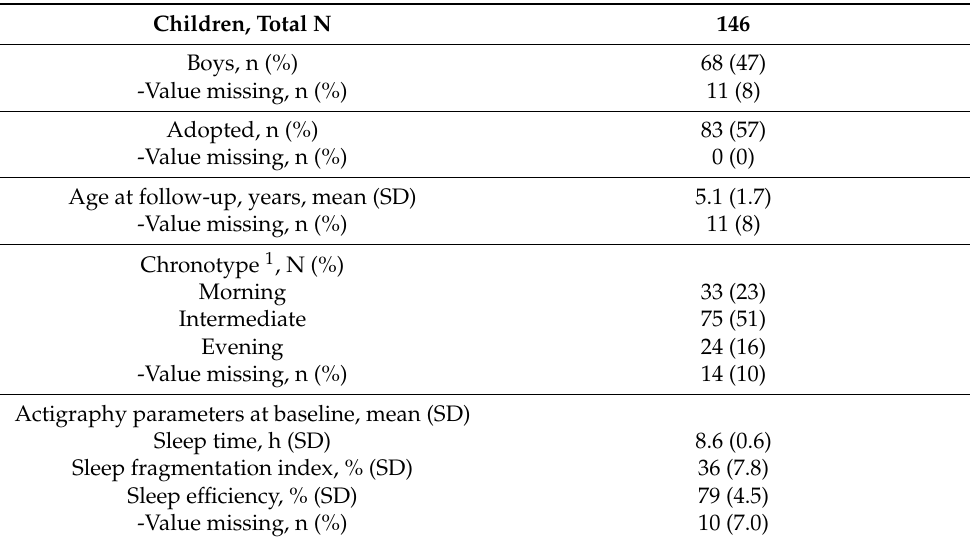
Table 1. Characteristics of the children in the